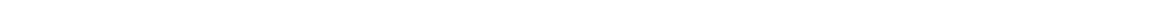
Fig. 3 DLC1 spatially restricts RHOA activity and regulates NC migratory behavior. a Schematic diagram of a full-length DLC1 and the dominant-negative DLC1 (DN-DLC1) containing the C-terminally truncated fragment of DLC1 without the RhoGAP and START domains. b Immunoblot for RHOA-GTP on protein lysates extracted from neural tubes electroporated with the indicated constructs at 24 hpt. Total RHOA is used as a loading control. Bars represent results from densitometric analysis (mean ± s.e.m., n = 3 independent experiments). Student ’ s t -test, * p < 0.05; ns, not signi fi cant. c Processed FRET signal images of cross-sections from embryos electroporated with the FRET probe plus DLC1 or DN-DLC1. NCCs are marked by SOX9 immuno fl uorescence and nuclei are stained with DAPI. The magni fi ed area and selected cells are marked with dotted squares. White arrowheads indicate FRET signal. Scale bars, 20 µ m. d Quanti fi cation of the total FRET index in control ( n = 425/25 embryos), NCCs expressing DN-DLC1 ( n = 148/21 embryos) and DLC1 ( n = 131/16 embryos). Student ’ s t -test, ** p < 0.001; *** p < 0.0001. e – l Immuno fl uorescence for SOX9, SOX10, HNK-1, Laminin and N-Cad on transverse sections of embryos electroporated (EP) with DLC1 at 24 hpt ( n = 12). Insets show the merge images of GFP and endogenous SOX9 or SOX10 expression. White triangle indicates endogenous HNK-1 expression in migratory NCCs, whereas open triangles indicate reduced expression of HNK-1, Laminin and N-Cad on the transfected side of the neural tube. Scale bars, 50 μ m. m , n Immuno fl uorescence for HNK-1 in an embryo electroporated with DN-DLC1 at 24 hpt ( n = 17). Scale bar, 150 μ m. o , p Cross-section at the level of the white line in m and n. White triangles indicate endogenous HNK-1 expression in migratory NCCs, whereas open triangles indicate reduced HNK-1 expression in the transfected side. q – t Immuno fl uorescence for SOX9, SOX10, N-Cad and Laminin on transverse sections of embryos electroporated with DN-DLC1 at 24 hpt ( n = 17). Insets show merge images of green and red channels. Scale bar, 50 μ m. u Quanti fi cation of the number of emigrating GFP + cells expressing HNK-1 in the transfected side of the neural tube electroporated with the indicated constructs. Average of cells counted from at least 30 sections of 10 embryos per treatment. Mean ± s.e.m. Student ’ s t -test ** p <